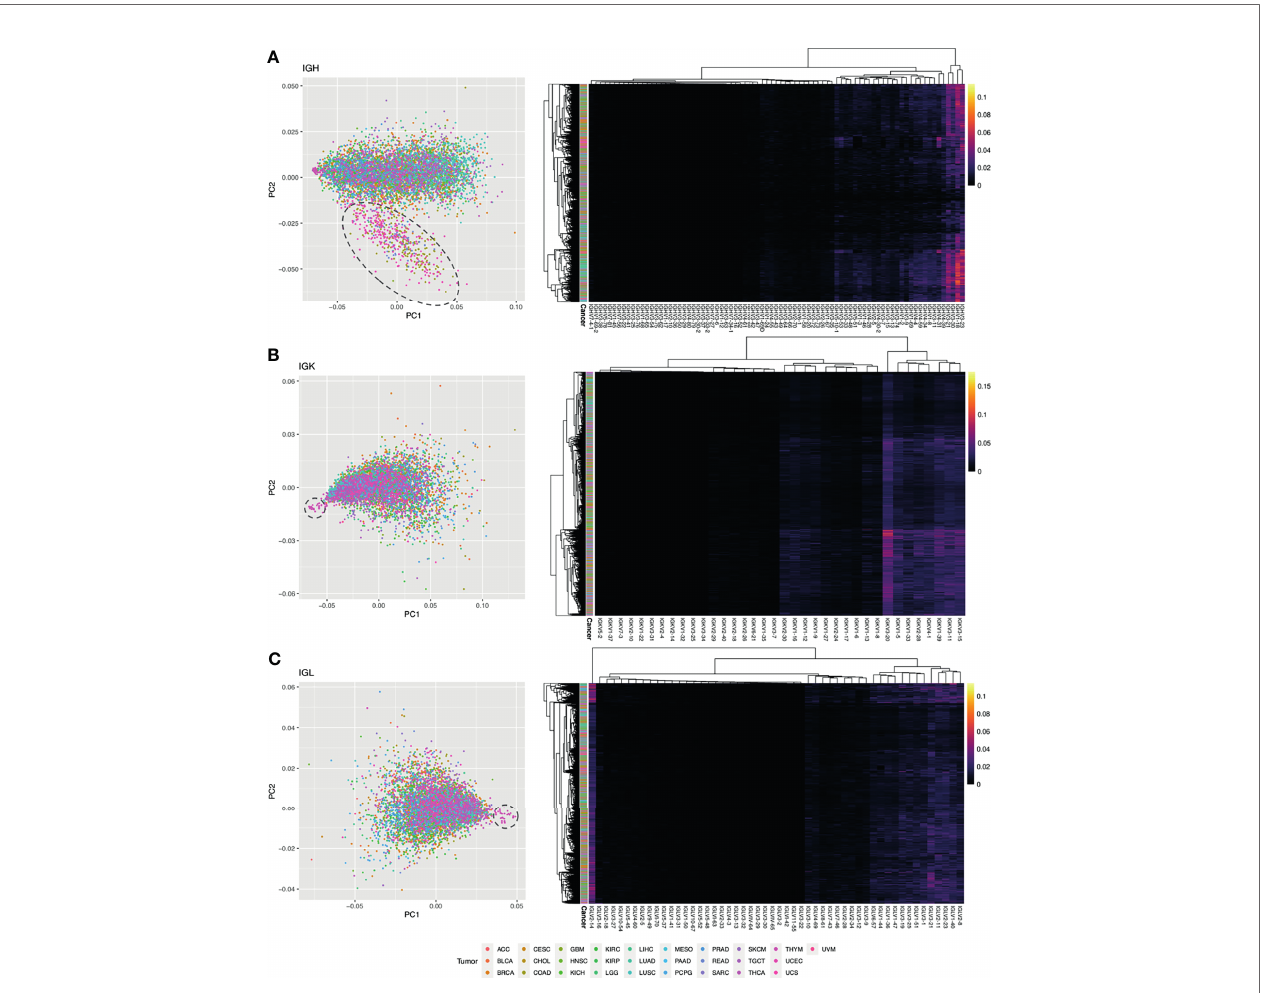
FIGURE 7 | Analysis of V gene usage. (A) PCA plot using IGH V gene usage data. Each point is a sample and the color of the point corresponds to a tumor type. A dashed circle is drawn around a cluster of COAD, READ, and UCEC samples. On the right is a heatmap with hierarchical clustering performed on the samples and the IGH V gene usage data. The intensity of the heatmap corresponds to the percent of clones using each V gene. (B) PCA plot using IGK V gene usage data. A dashed circle is drawn around a cluster of THYM samples. On the right is a heatmap with hierarchical clustering performed on the samples and the IGK V gene usage data. (C) PCA plot using IGL V gene usage data. A dashed circle is drawn around a cluster of THYM samples. On the right is a heatmap with hierarchical clustering performed on the samples and the IGL V gene usage